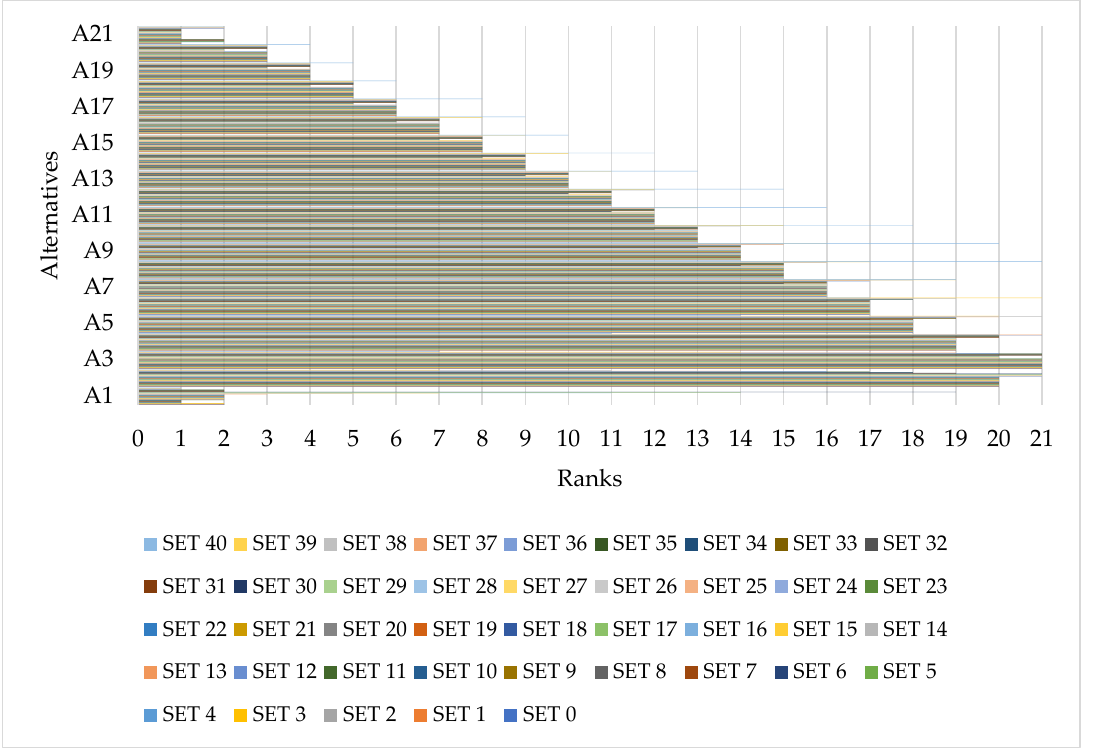
Figure 4. Ranks of alternatives when changing the values of the criteria.